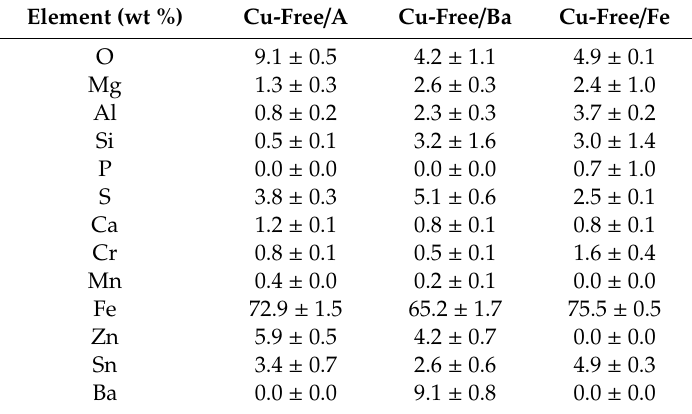
Table 4. Elemental composition, in weight percentage, of the secondary plateau from cross section of the three friction materials.